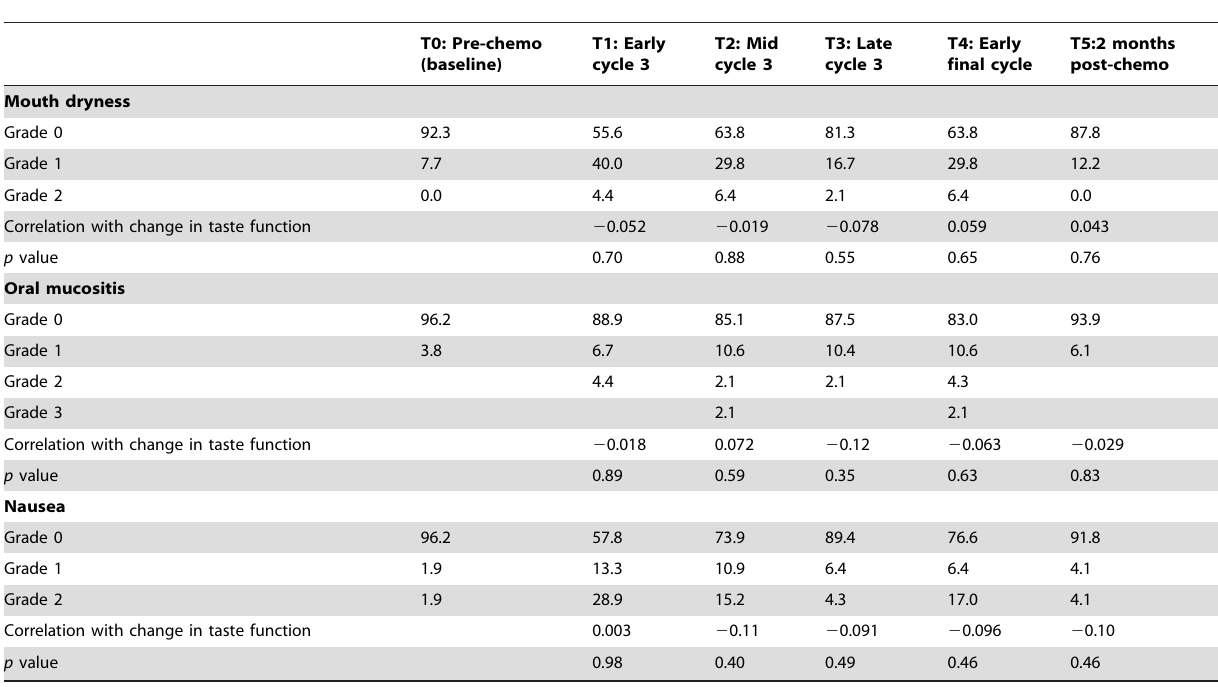
Table 5. Presence of mouth dryness, oral mucositis and nausea at each time point and association between each toxicity and change in taste